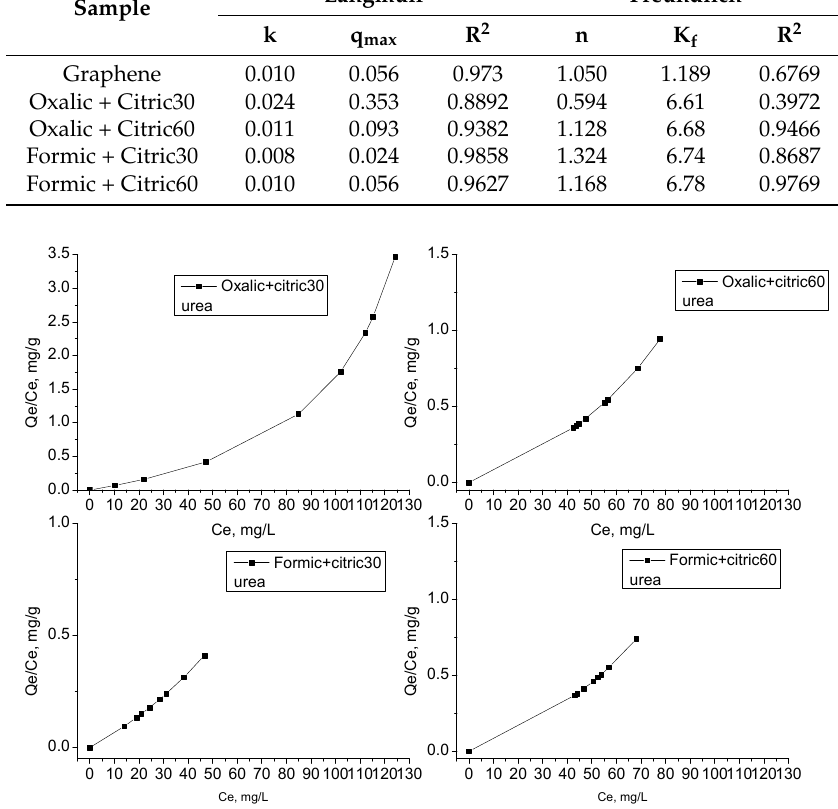
Figure 11. Langmuir model of adsorption for urea on graphene and modified graphene with organic acids samples.